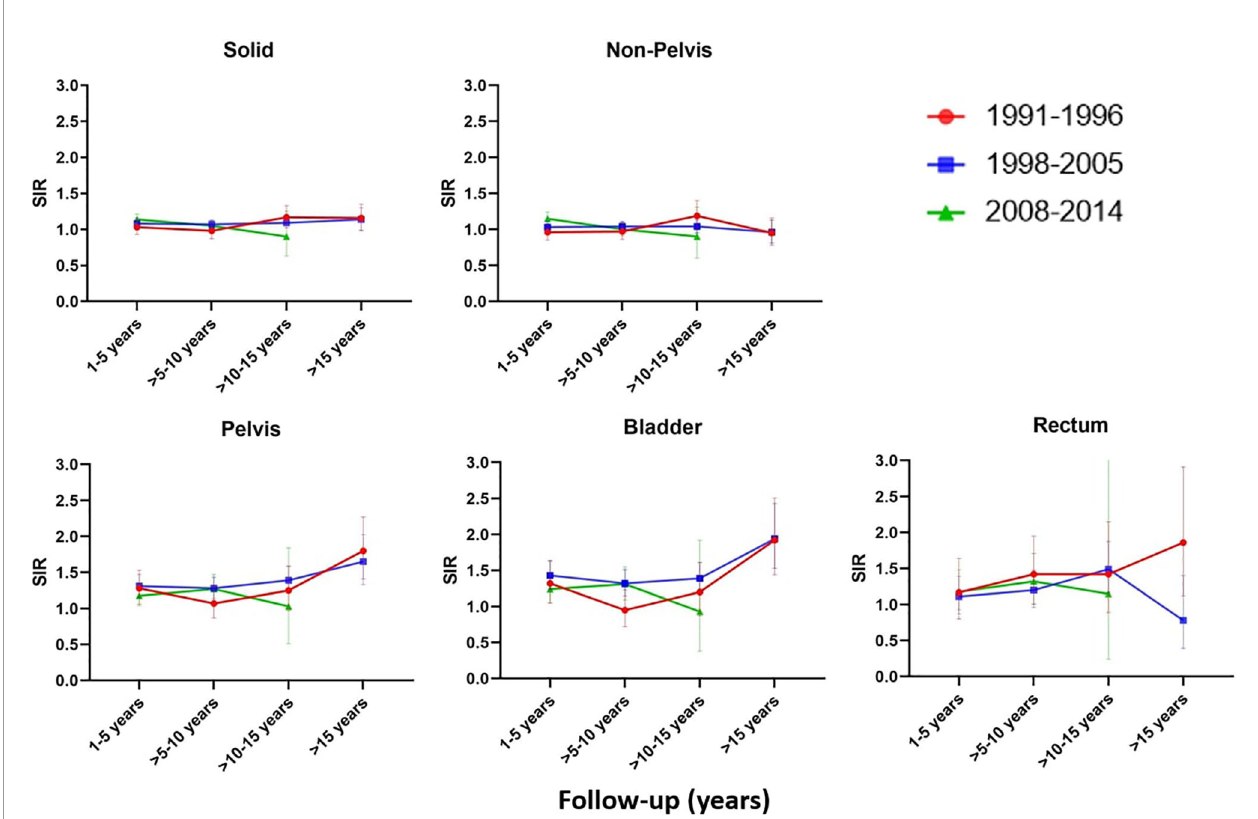
FIGURE 1 | SIR for the EBRT cohort compared to the Dutch male general population for different follow-up years and time